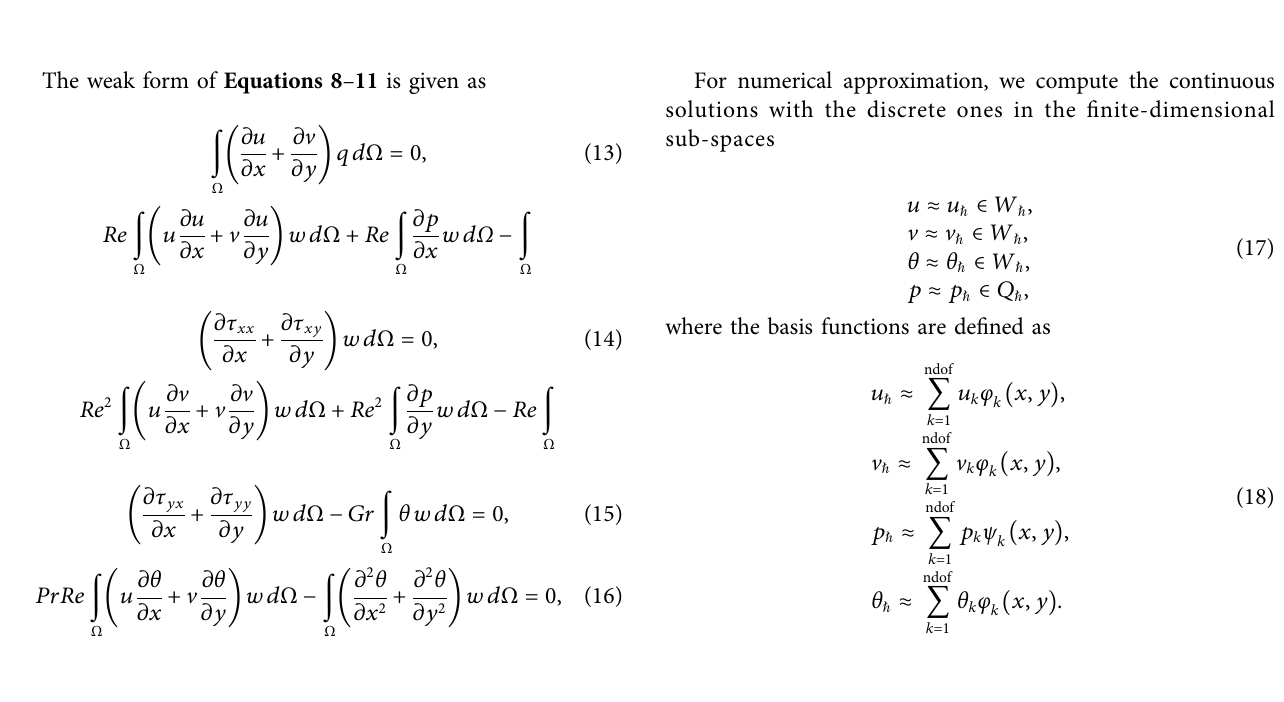
Frontiers in Physics |